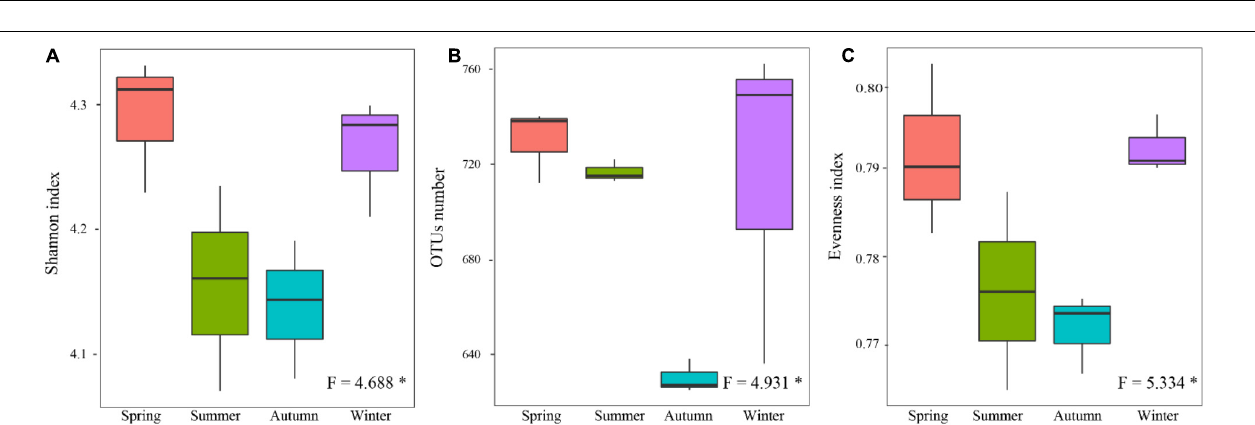
FIGURE 3 | Ordination analysis of the variation in rhizospheric soil bacterial communities. (A) Non-metric multidimensional scaling (NMDS) plots of the variation in the rhizospheric soil bacterial communities of P . tabulaeformis forest based on the profiles of presence/absence of genus; (B) Principal component analysis (PCA) of the rhizospheric soil bacterial communities of P . tabulaeformis forest based on the genus abundance and soil physicochemical characteristics as variables.